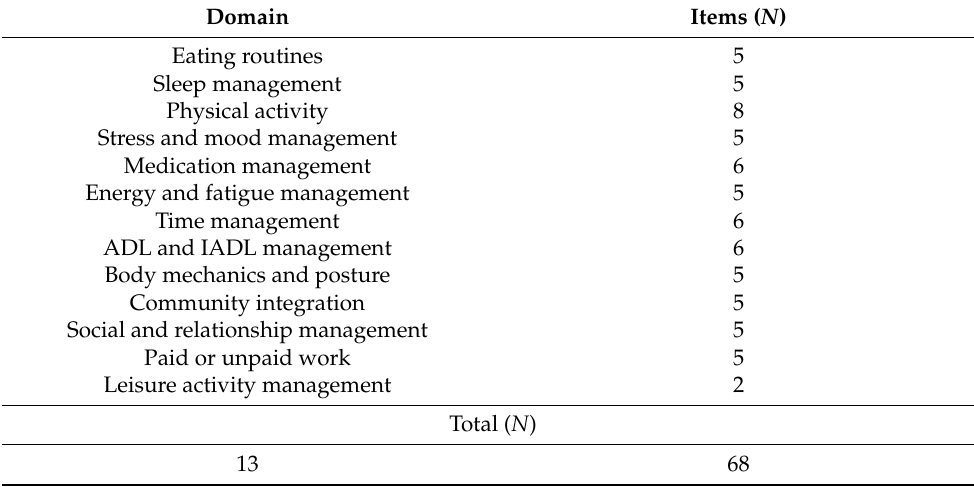
Table 2. Domain and items from the first Delphi